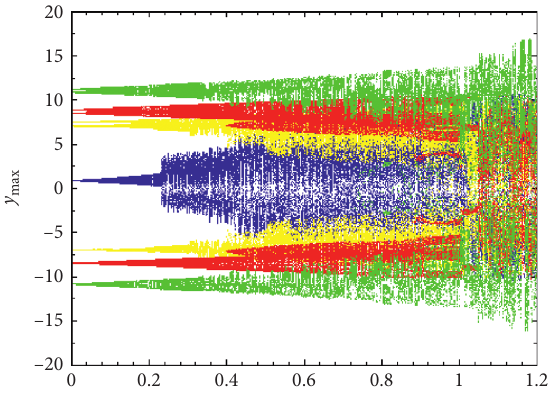
Figure 6: Nested bifurcation diagrams of local maxima of “ y ” versus forcing amplitude A in system (28) with w � 0 . 7. Four sets of data are superimposed with initial conditions blue (1, 0.2), black (25, 0.2), red (30, 0.2), and green (43, 0.2) without reinitiating.